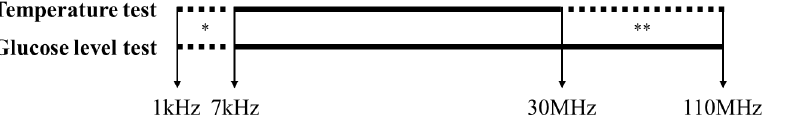
Figure 3. The frequency range for the fitting of each test. * This range is not used in both experiments because of an unknown noise in the frequency range of the 1kHz to 7 KHz. ** This range is not used in temperature test because a probe kit generates noise in the frequency range of the 30MHz to 110MHz.